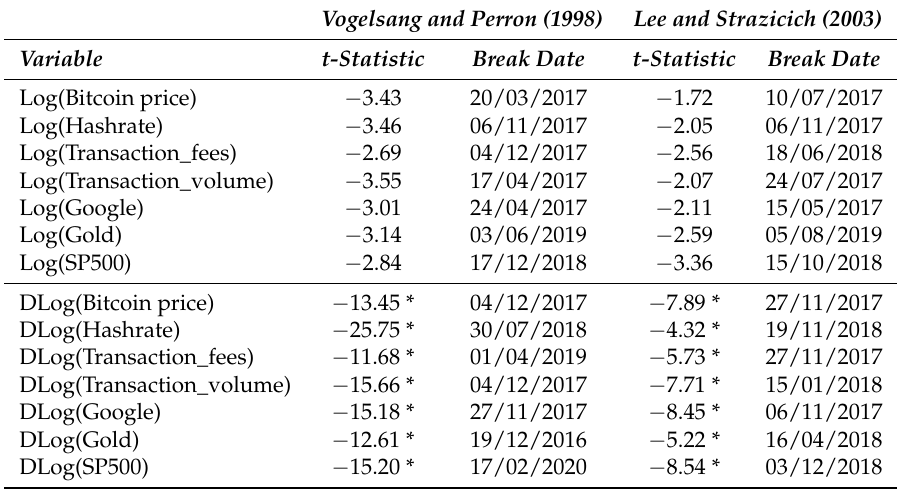
Table 2. Unit root tests. Null hypothesis: the time series has a unit root. * Significant at the 5%